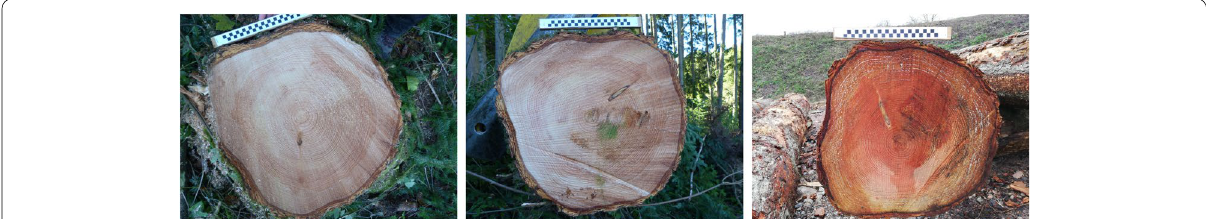
Fig. 15 Example of images of log #1 from tree #2 with: one stump image on the left; one corresponding image of the large log‑end taken in the forest; one image of the same log‑end taken on the logyard at the sawmill several weeks later. The 25‑cm‑long scale was used to calibrate each image